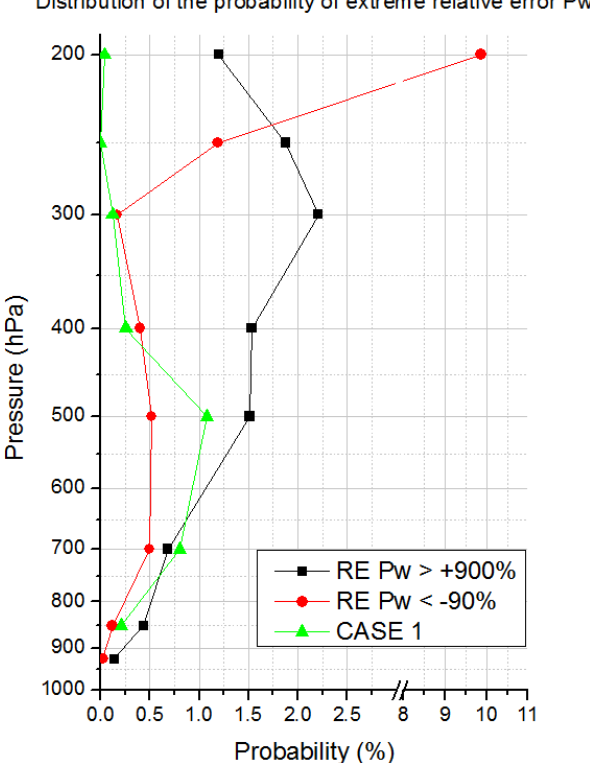
Fig. 7. Distribution of extreme relative error of water vapor pres- sure. The black curve shows the probability of data whose relative error of water vapor pressure is larger than +900%, the red curve shows the probability of data whose relative error of water vapor pressure is smaller than − 90%. The green curve shows the proba- bility of case 1 described in the